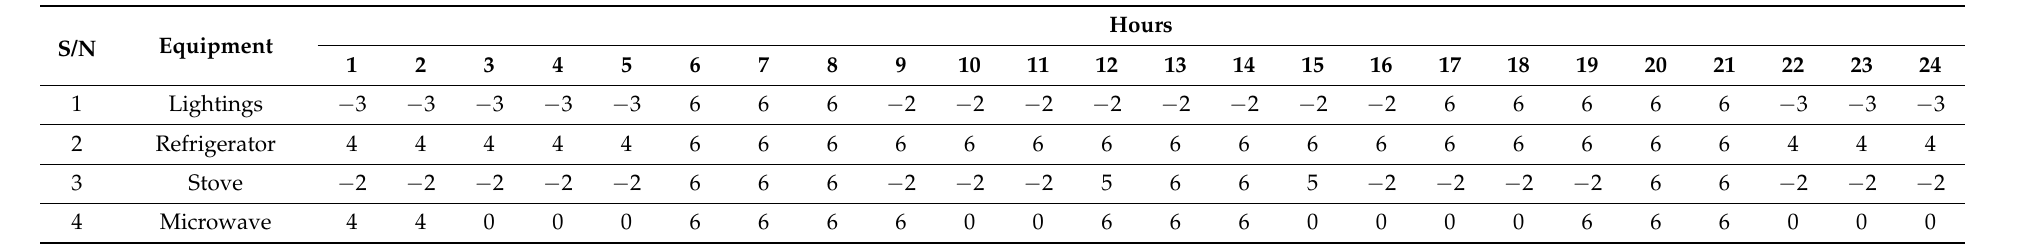
Table 3. Time-based satisfaction.